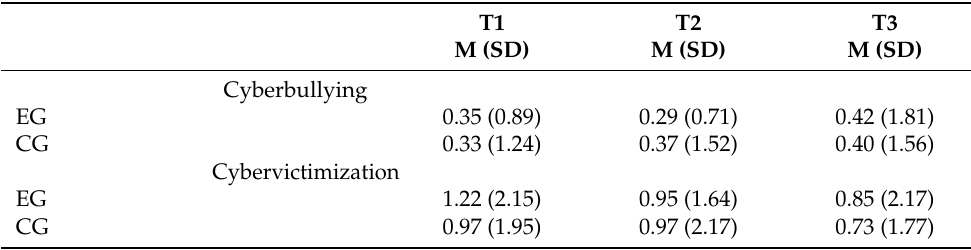
Table 3. Mean and standard deviations of cyberbullying and cybervictimization across conditions over time.